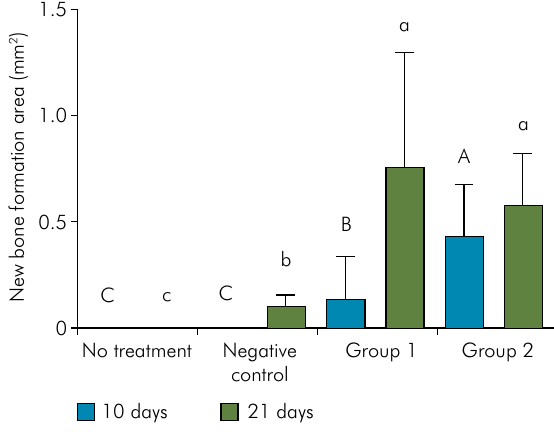
Figure 4. Extent of bone necrosis in different groups after the indicated time periods ( p < 0.05 was considered as significant). Upper-case letters indicate significant differences between necrosis on 10 days. Lower-case letters indicate significant differences between necrosis of 21 days.